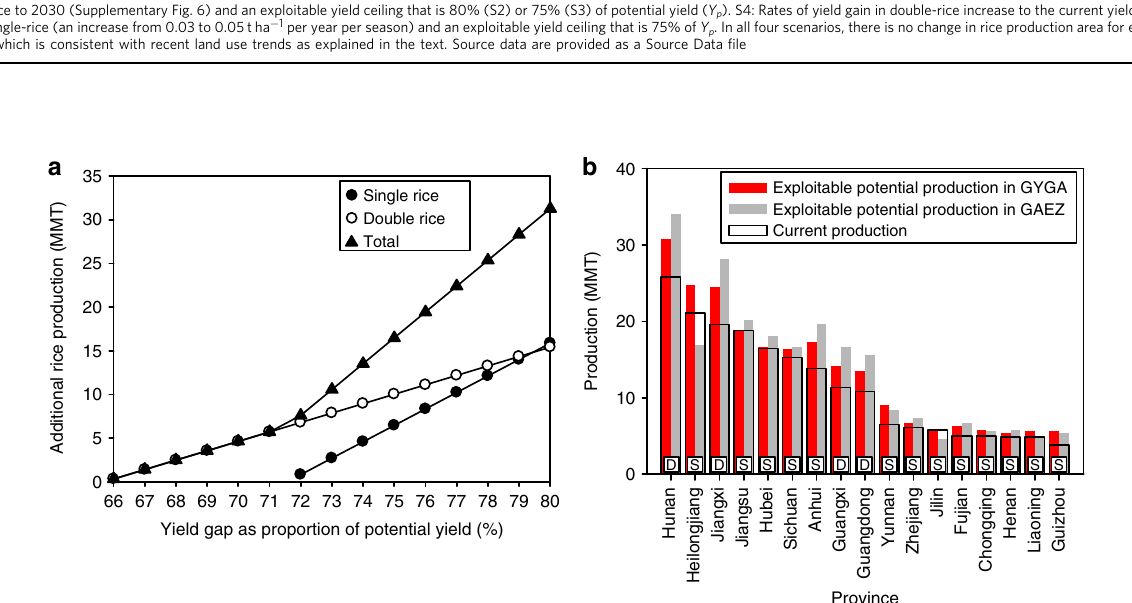
S1: Farm yields stagnate at current levels to 2030. S2 and S3: Rates of yield gain follow current trajectories based on regression of national rice yields versus year since 1985 to present for single- and double-rice to 2030 (SupplementaryFig. 6) and an exploitableyield ceilingthat is 80% (S2) or 75% (S3) of potentialyield ( Y p ). S4: Rates of yield gain in double-rice increase tothe currentyield growth